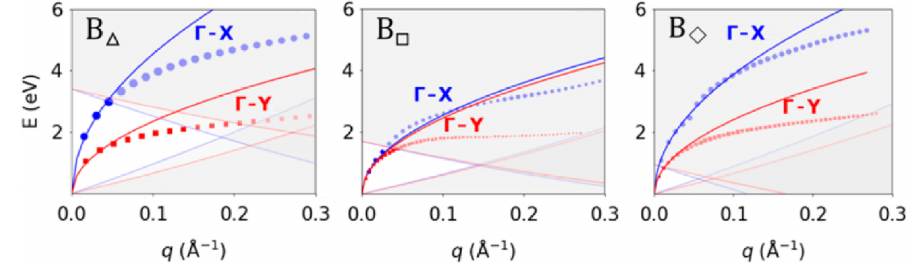
Figure 5: The plasmon dispersion of borophene polymorphs. Anisotropic plasmon dispersion ( q ) of buckled triangular (B Reproduced with permission [82]. Copyright 2017, American Chemical